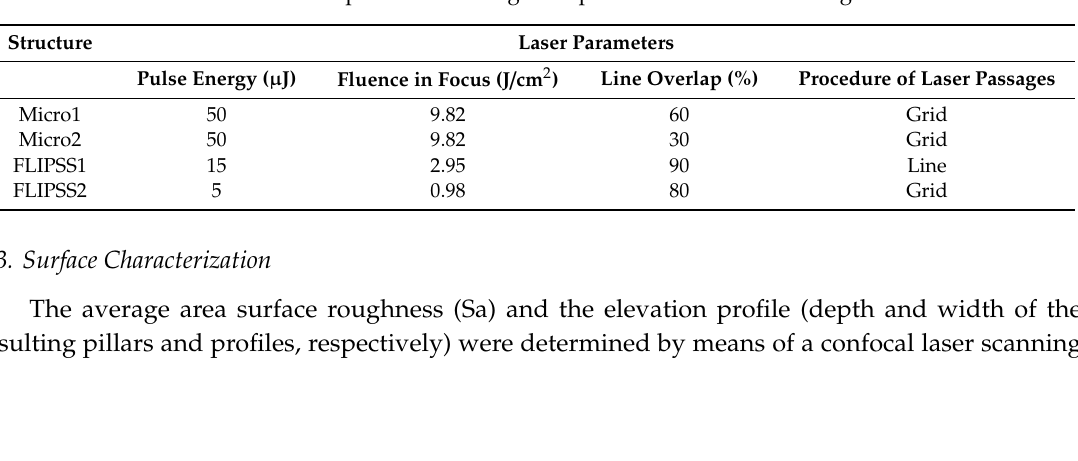
Table 1. Laser parameter settings and procedure of laser